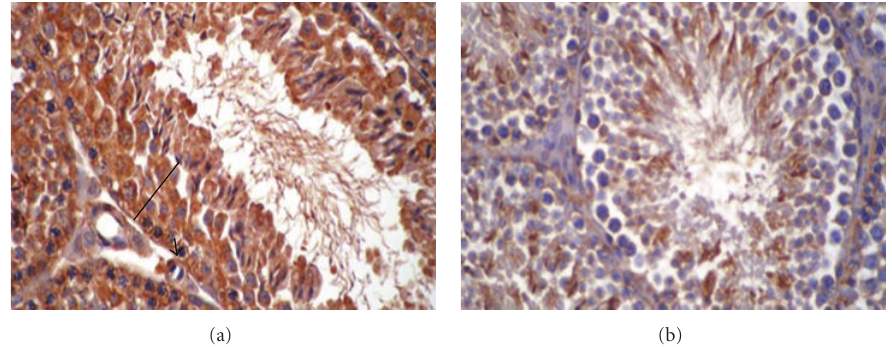
Figure 13: Actin Immunohistochemistry stain in seminiferous tubules. (a) Control animal showing positive immunoreactivity in Sertoli (arrow), Leydig ( ∗ ) and germinal cells (clasp). (b) After six weeks of treatment the immunoreactivity decreased in all the testicular cells.